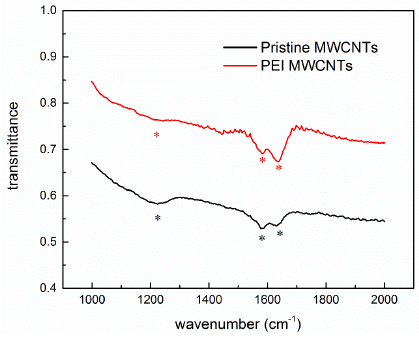
Figure 3. Fourier transform infrared spectroscopy (FTIR) spectra of pristine MWCNTs and PEI ‐ MWCNTs.